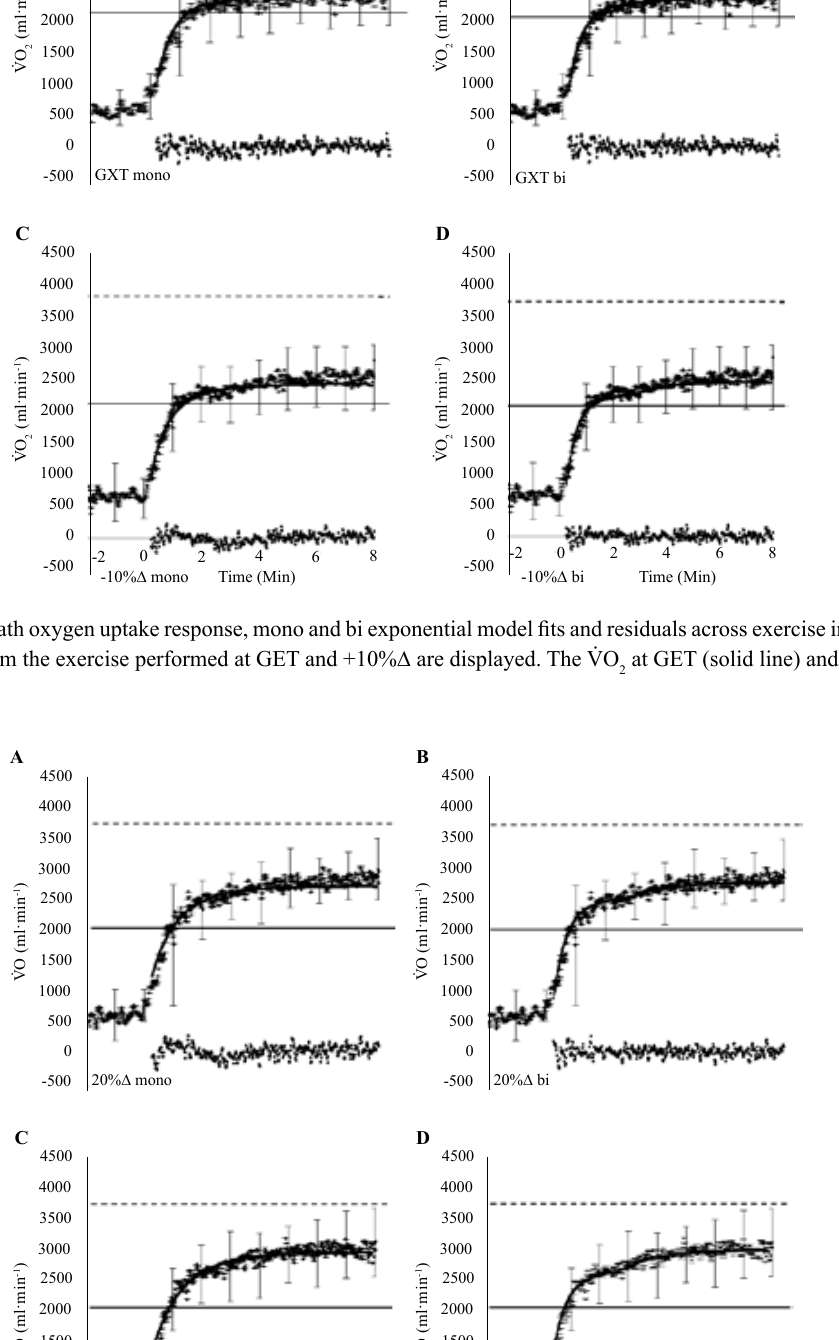
at GET (solid line) and V̇ O (dashed 2 2peak